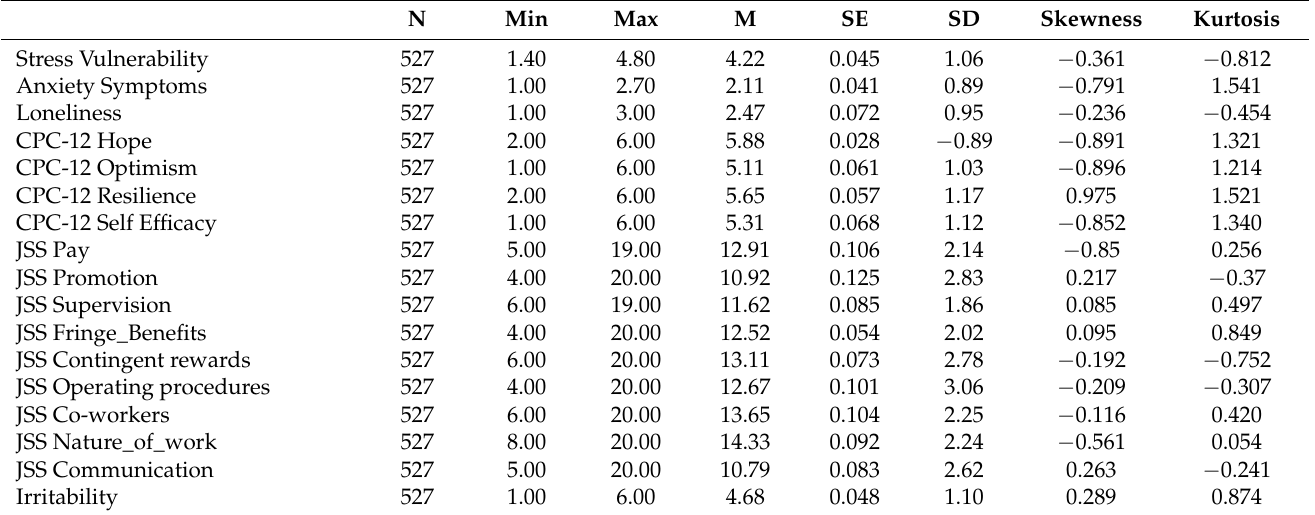
Table 1. Descriptive statistics (range [minimum/maximum], mean [M], including standard error [SE], standard deviation [SD], skewness and